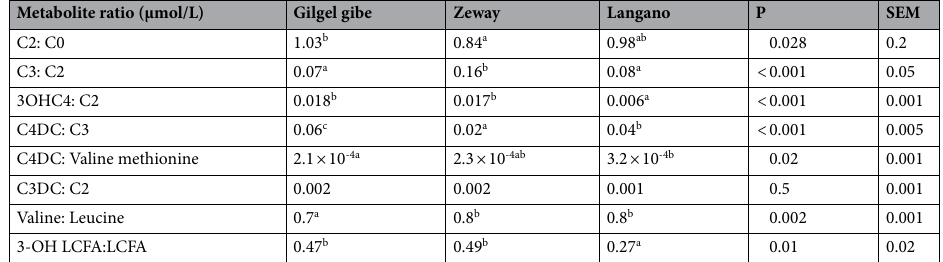
Table 4. Ratios of selected acylcarnitines and free amino acids in Nile tilapia blood from the three Ethiopian lakes. C2:C0 = acetyl carnitine: free carnitine; C3:C2 = propionyl: acetyl carnitine; 3OH-C4:C2 = 3-hydroxybutyryl: acetyl carnitine; C4DC:C3 = methylmalonyl: propionyl carnitine; C4DC:val + met = methylmalonyl carnitine: (valine + methionine); C3-DC:C2 = malonyl carnitine: acetyl carnitine; val: leu valine: leucine and 3-OH LCFA:LCFA = sum of 3-hydroxy-long-chain fatty acids: sum of long-chain fatty acids. SEM = standard error of the mean. a,b,c, Mean values with different letters within the row are significantly different ( P <